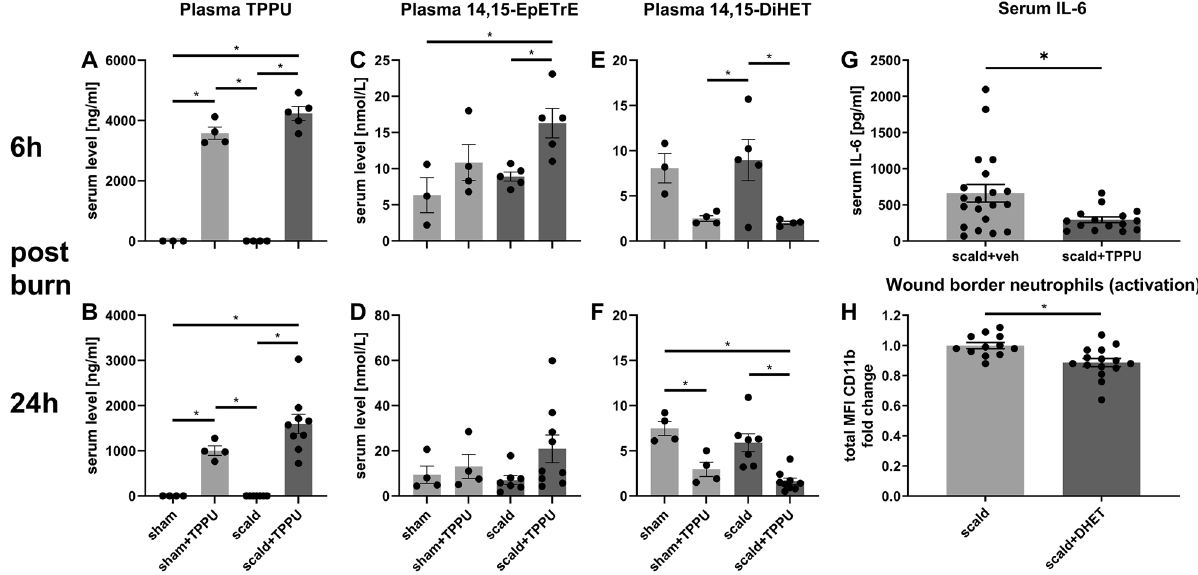
Figure 1. Acutely after burn injury TPPU decreases serum DHET levels and serum IL-6 levels, which prevents DHET induced decrease of neutrophil activation. TPPU increases the serum 14,15-EpETrE levels and decreases serum 14,15-DHET levels after burn injury. TPPU is an inhibitor of soluble epoxide hydrolase (sEH), which converts 14,15-EpETrE into 14,15-DHET. 10 mg/kg body weight TPPU in polyethylene glycol 400 (PEG) or PEG as control were administered intraperitoneally directly post-burn or sham intervention in male CD1 IGS mice (n = 3–5/group). Injury was inflicted by a third degree burn of 28% of total body surface on the back and blood was harvested after 6 or 24 h. Serum levels of TPPU, 14,15 EpETrE and 14,15-DHET were assessed using mass spectroscopy ( A – F ). Serum levels of IL-6 were analyzed using Cytometric Bead Array after 6 h (n =